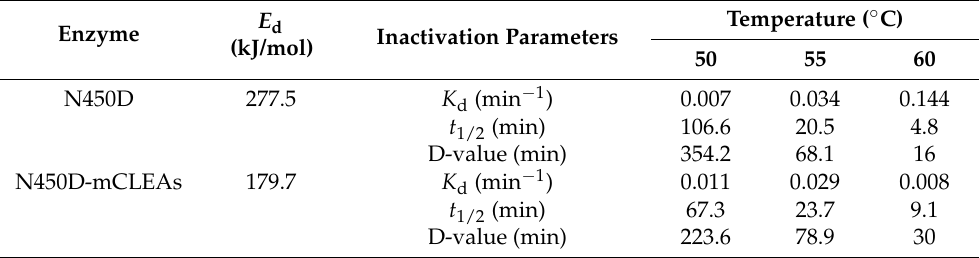
Table 1. Inactivation parameters of N450D and N450D-mCLEAs.